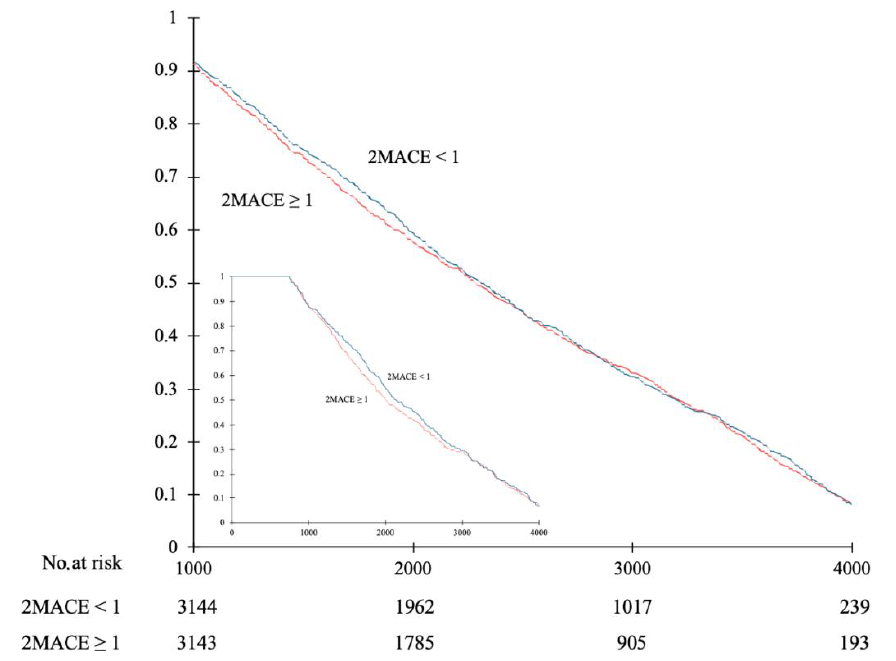
Figure 6. Kaplan – Meier survival analysis of all-cause mortality in relation to the 2MACE score in the overall study population (large graph). The inner graph represents the comparison in patients with atrial fibrillation.